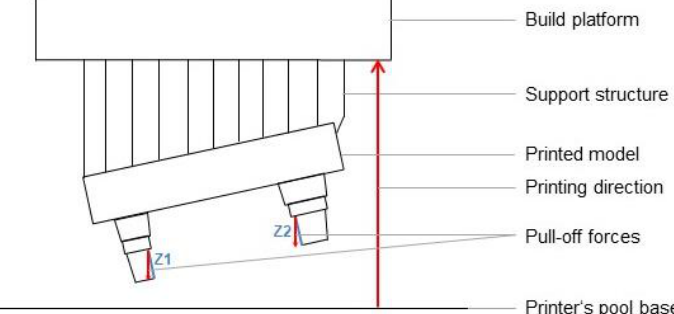
Figure 8. Graphical representation of the relation between pull-off forces and surface roughness in overhang areas. Z1, Z2: measurement directions in the vertical dimension.